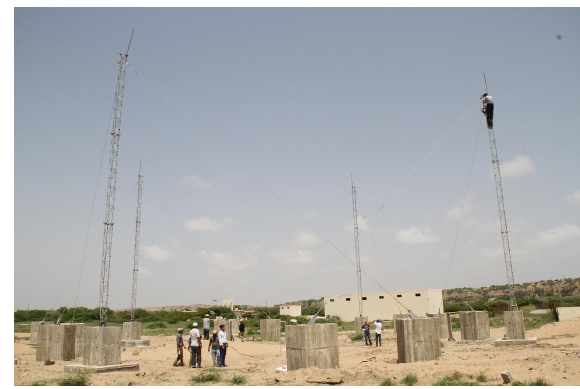
Figure 11. A view of the ionosonde antenna site at Sonmiani.